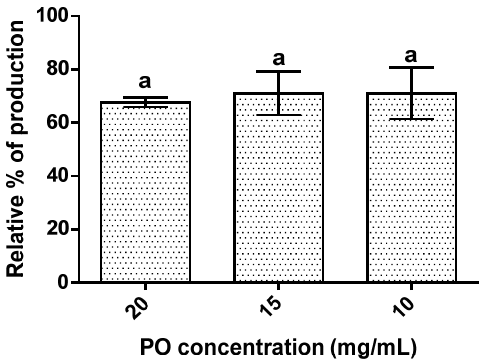
Figure 4. Hepatic lipid accumulation results for the different concentrations of pomegranate oil. Different letters represent significant differences as determined by the one-way ANOVA test ( p < 0.05).